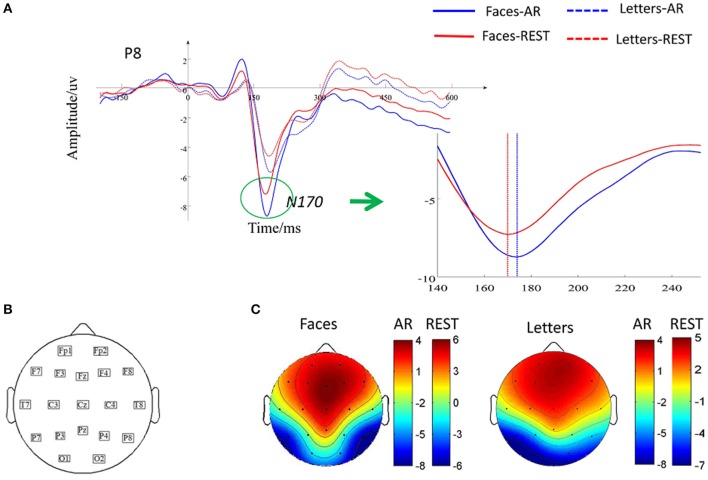
Effects of reference during N170 peak latency and amplitude. (A) Grand-averaged ERP for two kinds of stimuli across all subjects at P8. Solid waveform elicited by faces and dashed waveform elicited by letters, (B) Distribution of 19 scalp electrodes, (C) Topography of ERPs induced by faces and letters in AR and REST.